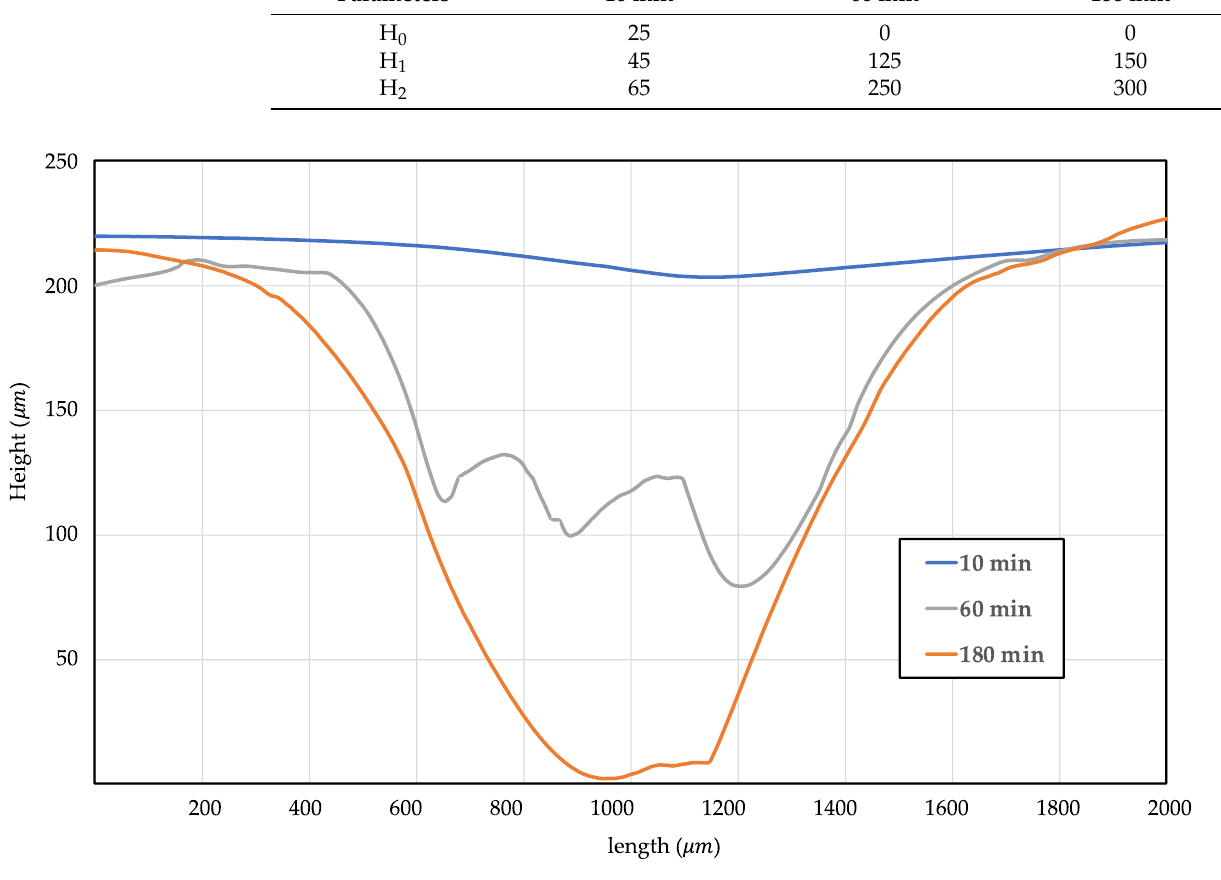
Figure 12. Height of macropatterning by compression stress of 3D-printing mold: AA’ line.